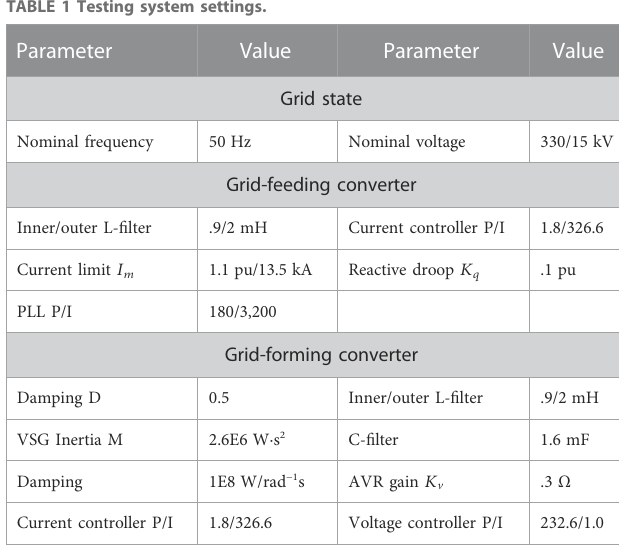
RTDS platform. Figure 3 (top) depicts the test system, where a slack generator is connected to the common bus of the wind generator and synchronous generator via a transmission line. The protection device